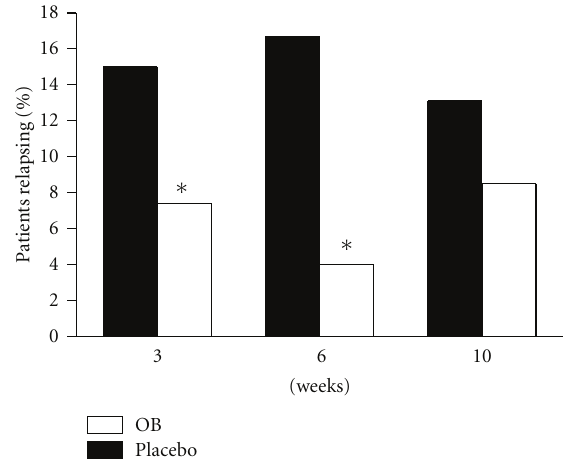
Figure 4: Percentage of the patients relapsing during the follow- up treatment free-period (at 3, 6, and 10 weeks) after 12 weeks treatment with placebo or otilonium bromide. ∗ P < 0 . 05 as compared to respective placebo group. From OBIS trial